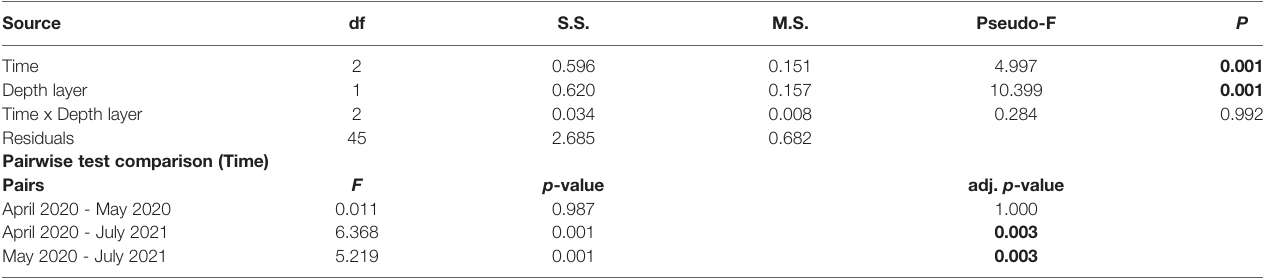
Signi fi cant values are highlighted in